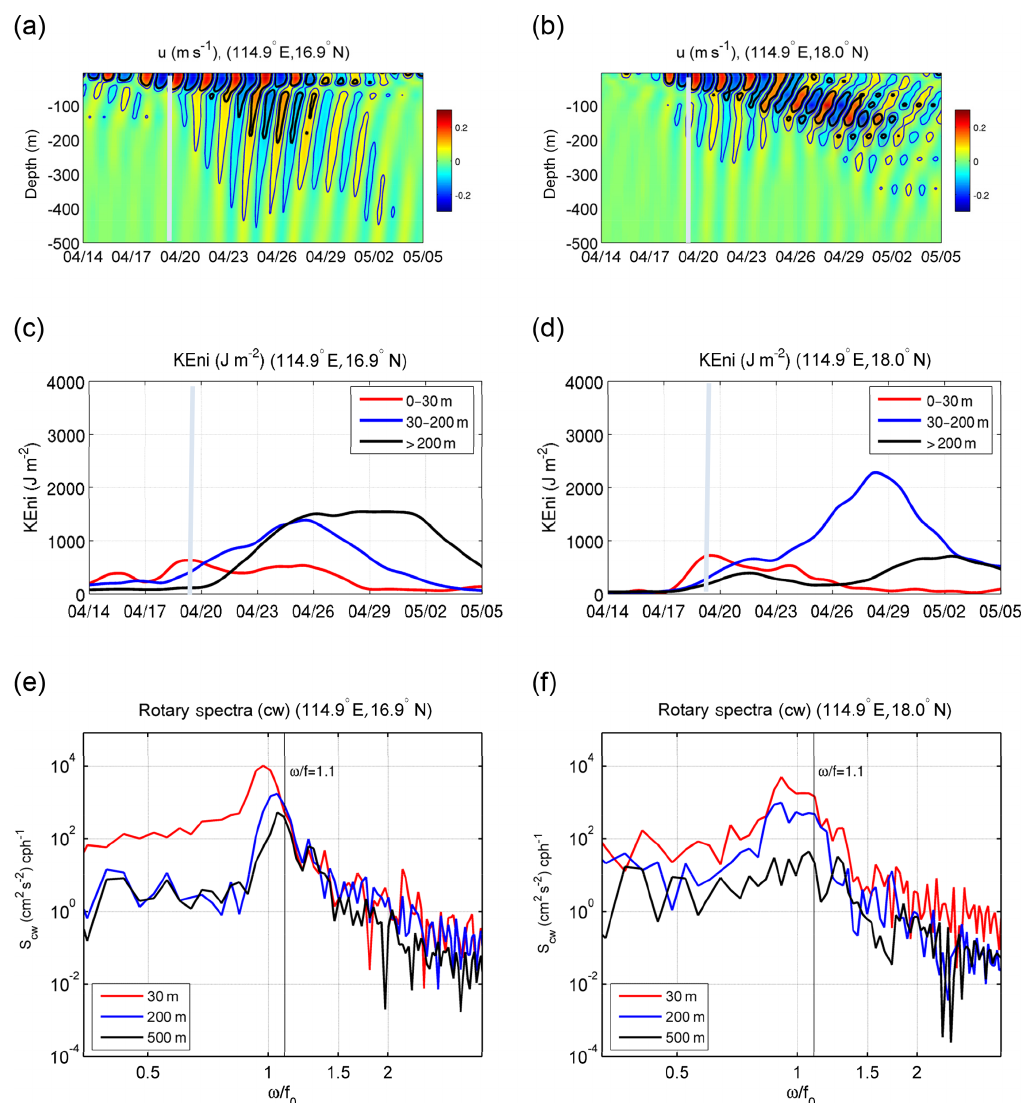
Figure 11. As in Fig. 9, except for locations C1 (a, c, e) and C2 (b, d, f) .